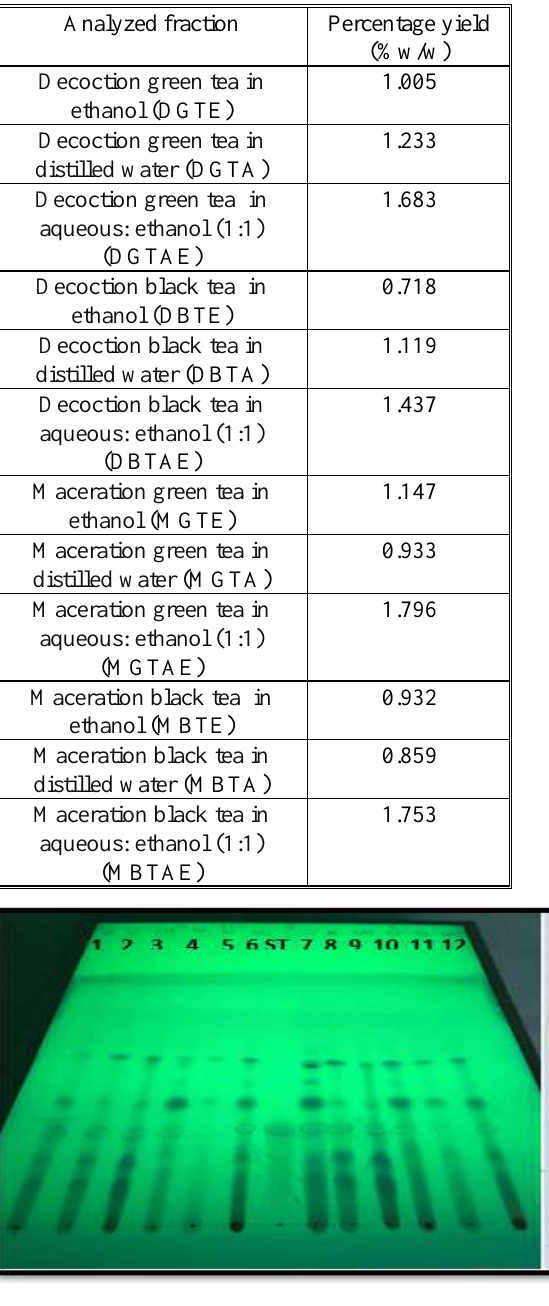
Figure 4. TLC chromatogram of ethyl acetate fractions of green and black tea, ST: epicatechin standard, 1: MGTA, 2: MGTE, 3: MGTAE, 4: MBTA, 5: MBTE, 6: MBTAE, 7: DGTA, 8: DGTE, 9: DGTAE, 10: DBTA, 11: DBTE, 12: DBTAE, using S1 as a solvent